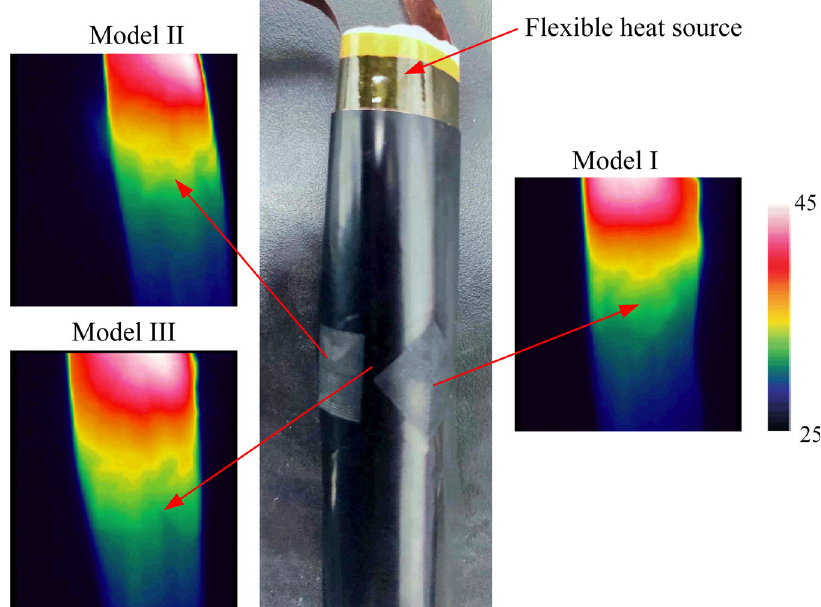
Fig. 4 Experimental performance evaluation of temperature maps to the arched thermal metasurface. A fl exible adjustable graphene heat source 72,73 is attached to the Model III and bend the Model III into an arch shape. Model I and II cannot interfere with each other during taking thermal distribution maps due to the arched thermal metasurface. The thermal distribution maps of the three models can be obtained by shooting from different angles in the same thermal